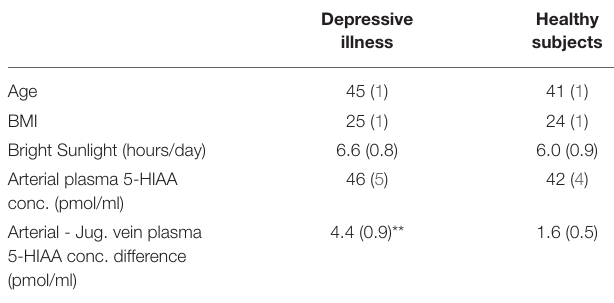
TABLE 1 | Brain 5HIAA overflow in panic disorder. TABLE 2 | Estimated brain 5HIAA overflow in depressive